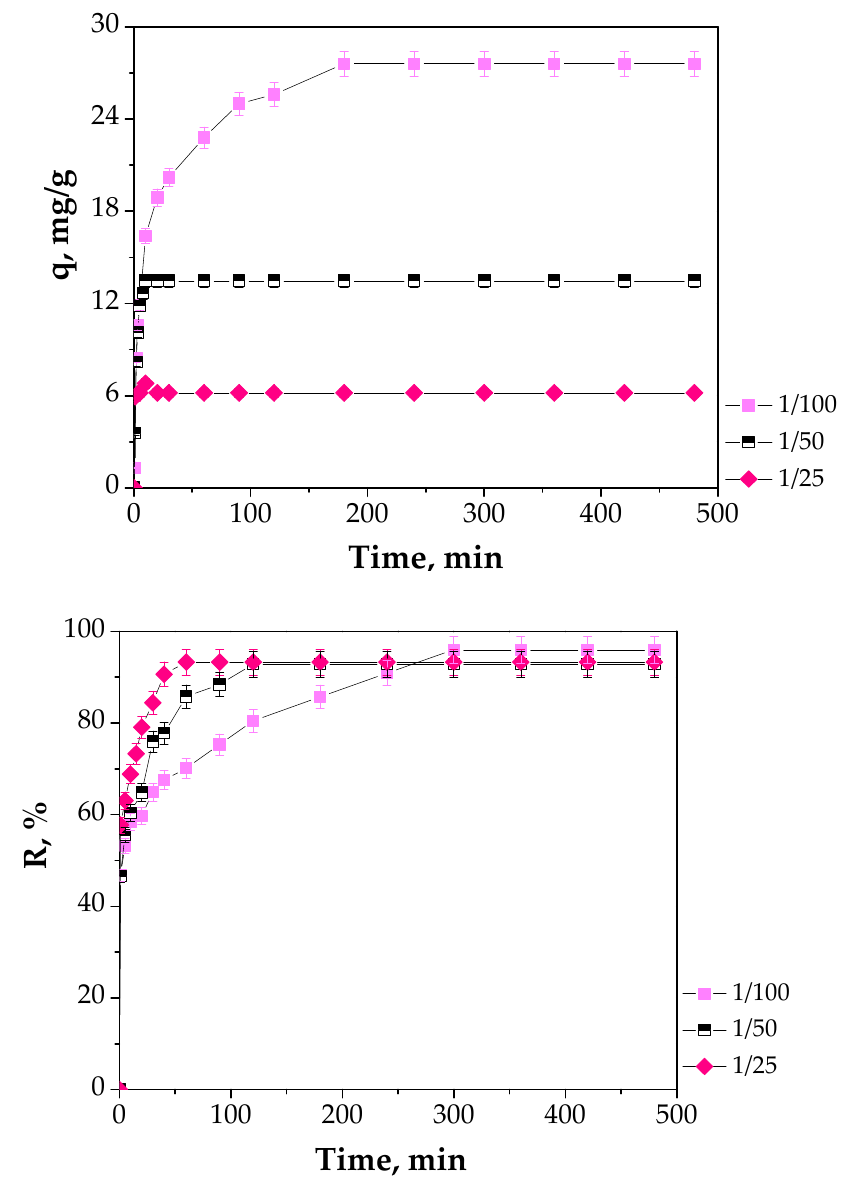
Figure 7. Effect of adsorbent dose.